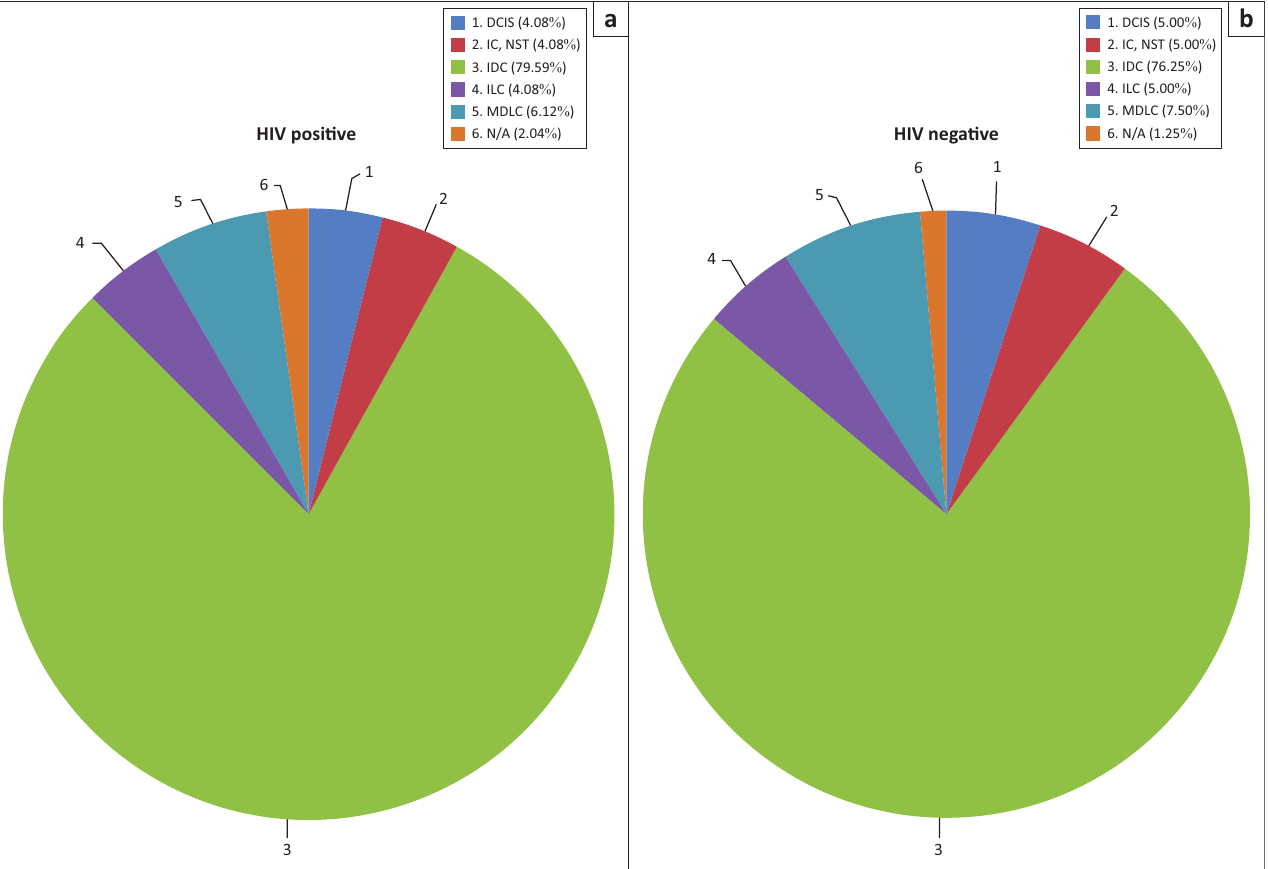
FIGURE 6: Percentages of different histological subtypes in relation to human immunodeficiency virus status: (a) HIV-positive and (b)